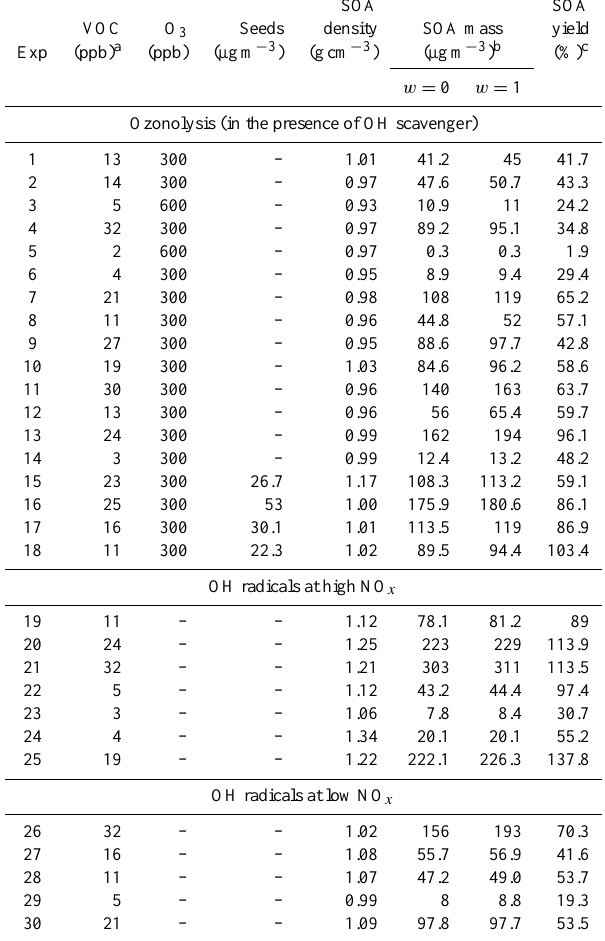
Table 1. Initial conditions and results of the β -caryophyllene oxi- dation